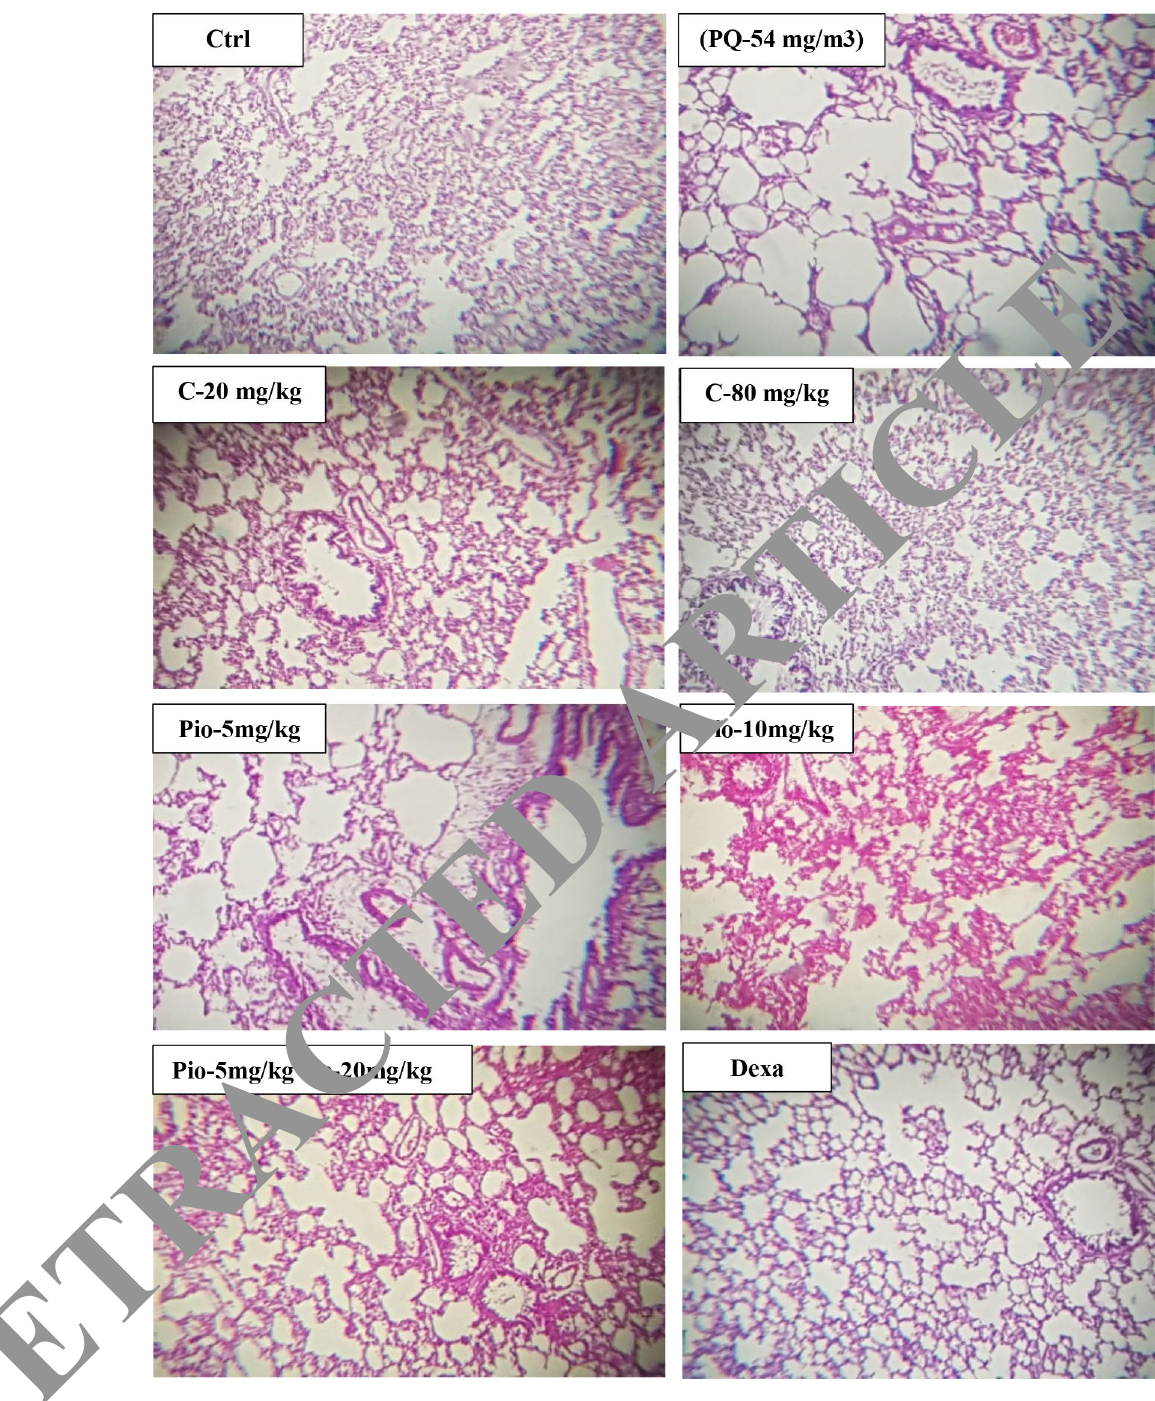
Figure 3. Lung specimens photographs of the control group (Ctrl), group exposed to paraquat aerosol at doses of 54 mg/m 3 (PQ-54 mg/m 3 ), groups exposed to PQ-54 mg/m 3 and treated with 5 and 10 mg/ kg/day pioglitazone (Pio-5 mg/kg/day and Pio-10 mg/kg/day), 20 and 80 mg/kg/day carvacrol (C-20 mg/ kg/day and C-80 mg/kg/day), 0.03 mg/kg/day dexamethasone (Dexa-0.03 mg/kg/day) and 5 mg/kg/day pioglitazone + 20 mg/kg/day carvacrol (Pio-5 mg/kg + C-20 mg/kg)., (Magnification: 10 ×